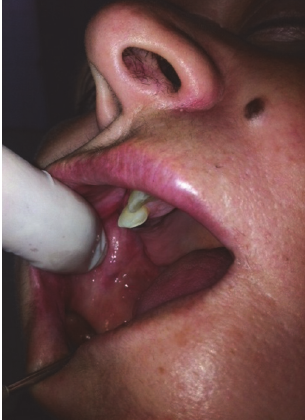
Figure 3: Second appointment after twelve days: regression of